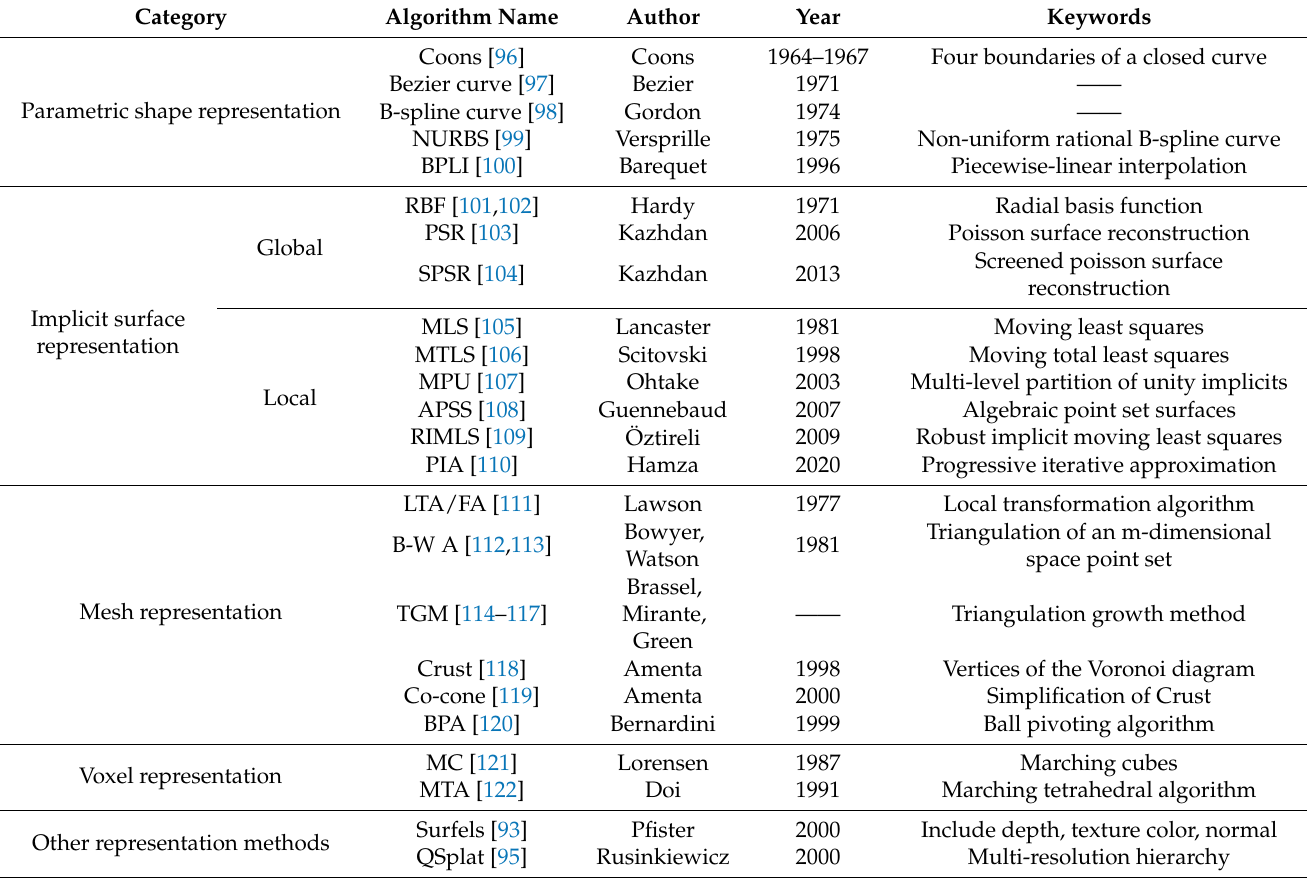
Table 3. A brief summary of classical representation